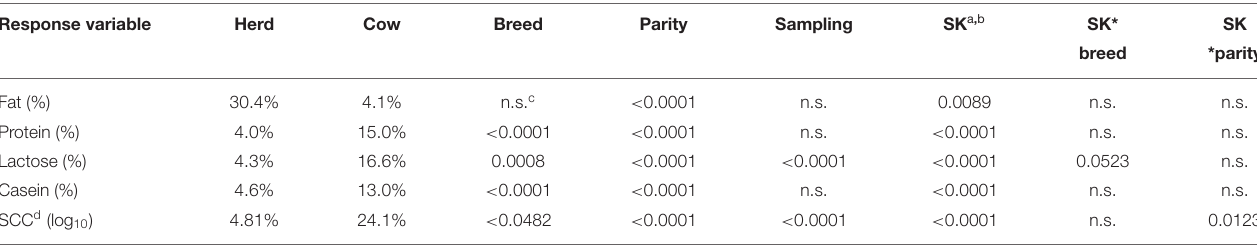
TABLE 2 | Proportion of variance for random effects (herd, cow) and significance of fixed effects on milk components and SCC resulting from HPMIXED analysis for the repeated measurements. Response variable